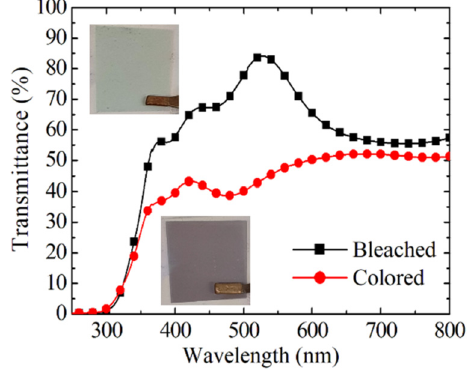
Figure 17. Transmittance spectra of the EC device fabricated by slot–die coating (the insets are photo images of the bleached and colored